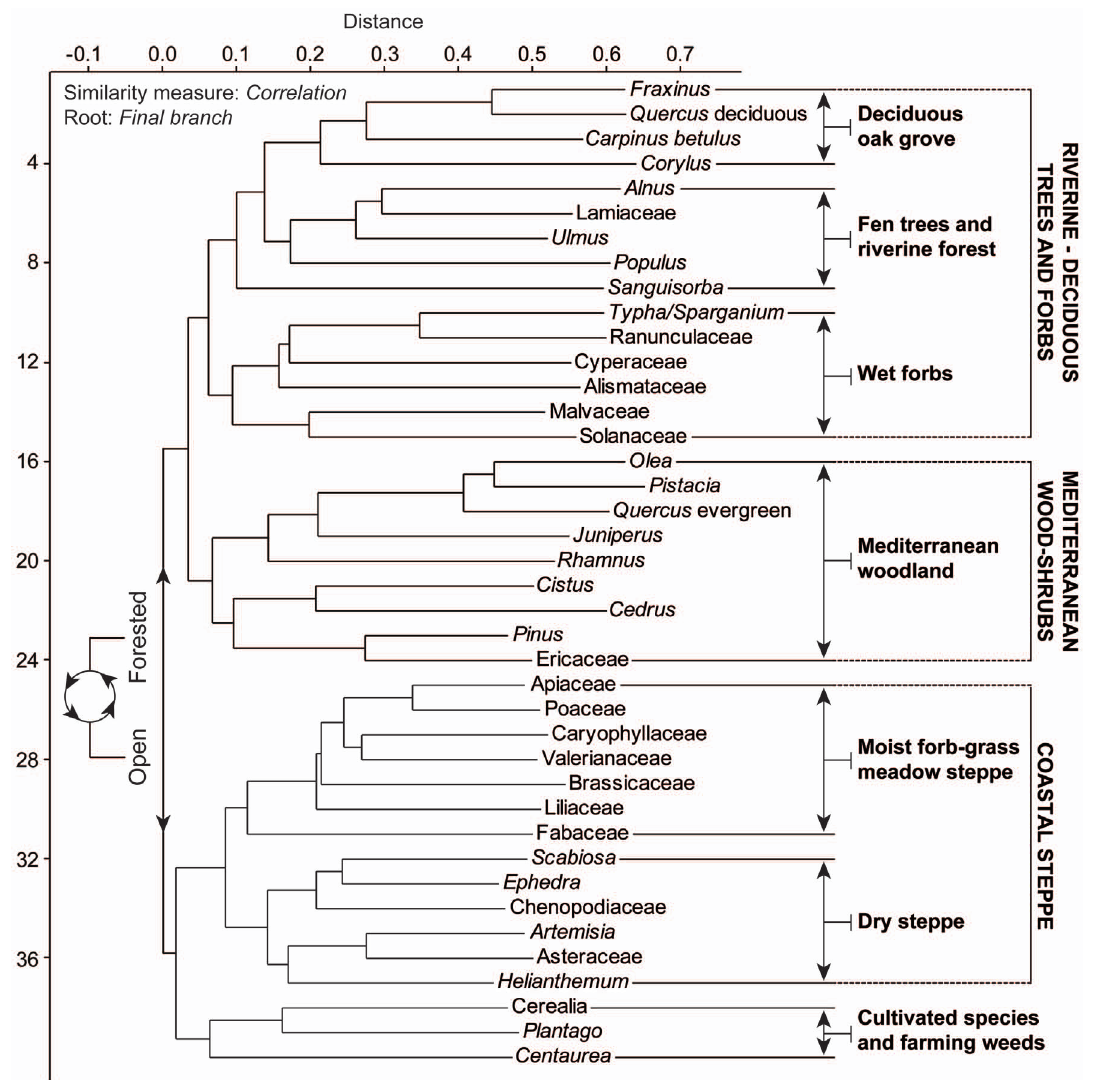
Figure 2. Neighbour Joining analysis of the main taxa from the core B 22 computed with correlation as similarity measure and final branch as root. The pollen-types from each cluster were summed to create pollen-derived vegetation